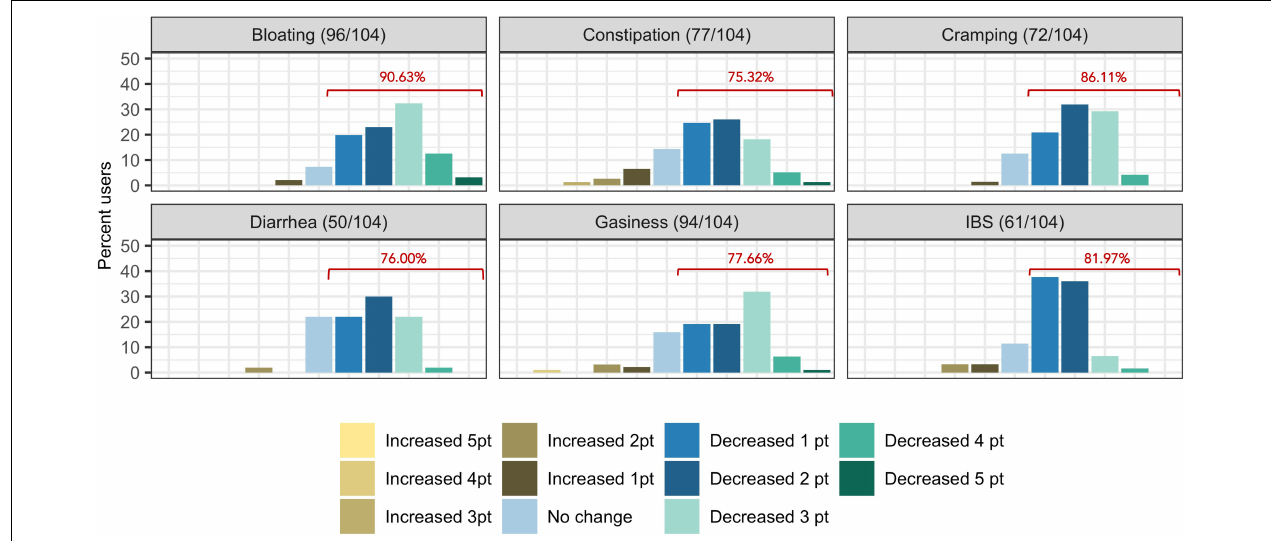
FIGURE 2 | Self-reported symptom severity change (number of levels increased/decreased severity) in functional gastrointestinal disorders from baseline to time of survey. Percentages displayed in red indicate the proportion of users who reported at least one point reduction is symptom